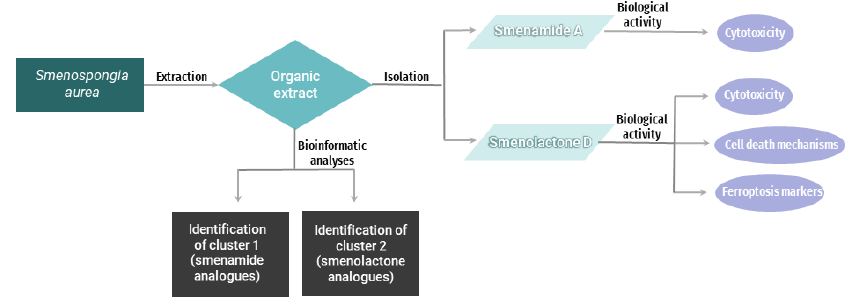
Figure 1. Single flow diagram representing the overall methodology adopted.